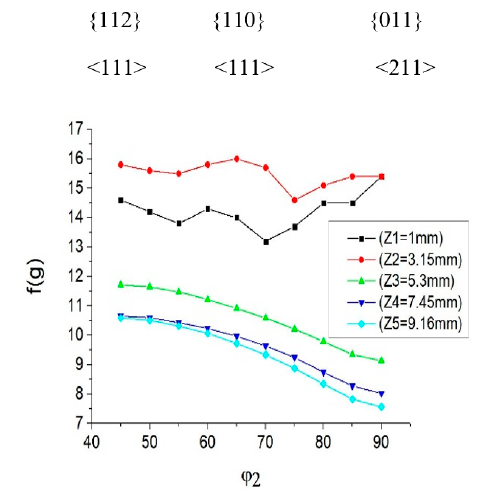
Figure 7. The β -fiber plot of Z1 to Z5.